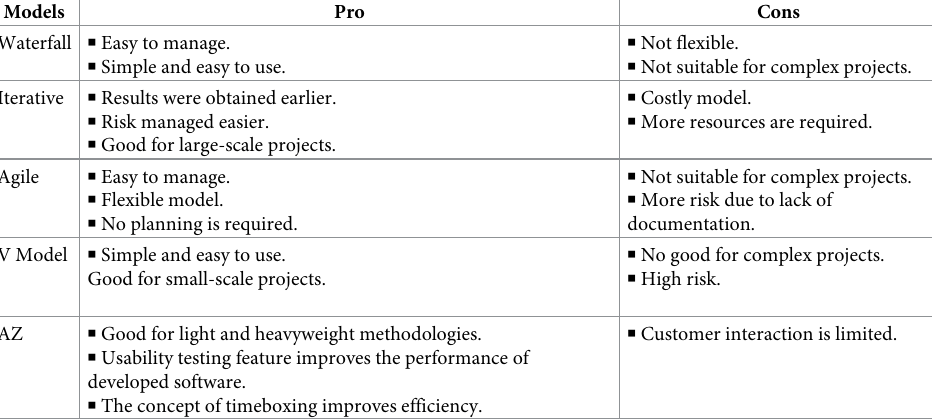
Table 3. Pros and cons of software development life cycle.